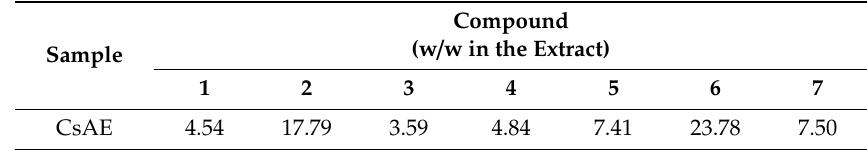
Table 1. The most important compounds identified in C. siliqua aqueous extract by UHPLC analysis.